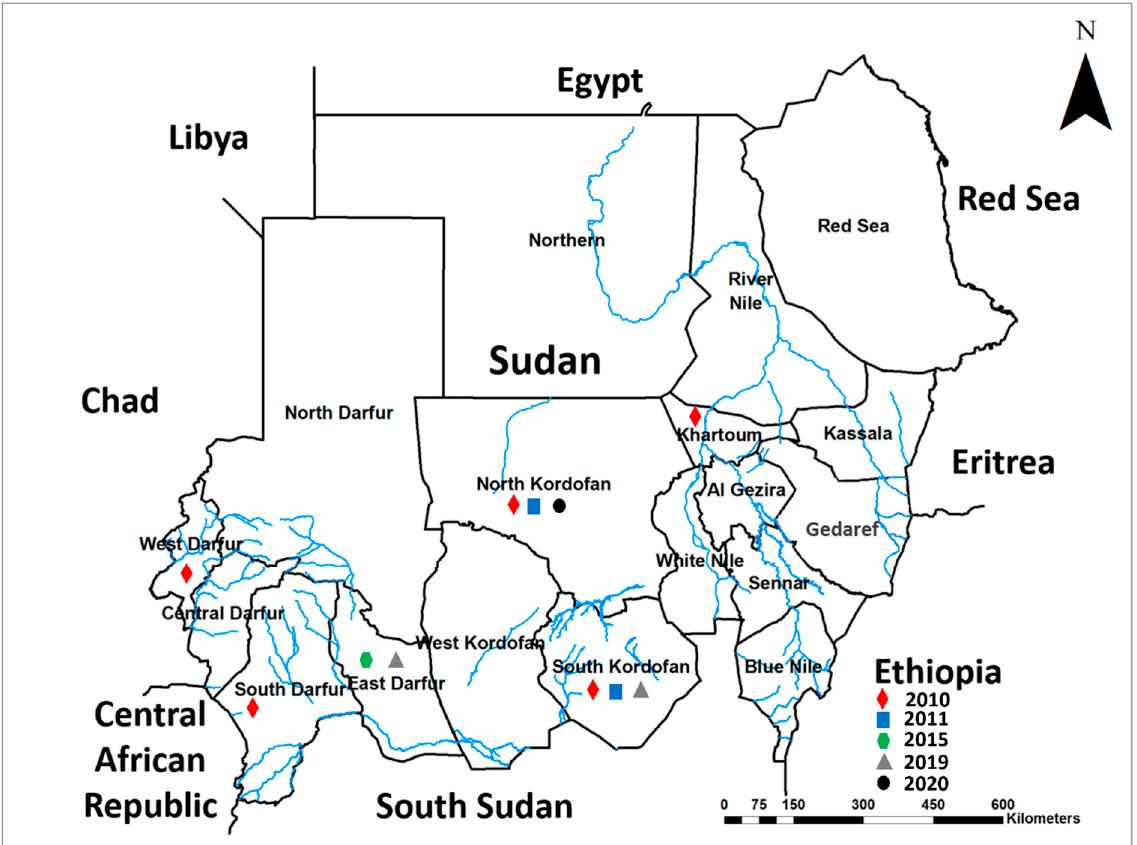
Figure 1. Geographical distribution of Crimean-Congo hemorrhagic fever (CCHF) epidemics in Sudan by years indicated by the colored shapes.